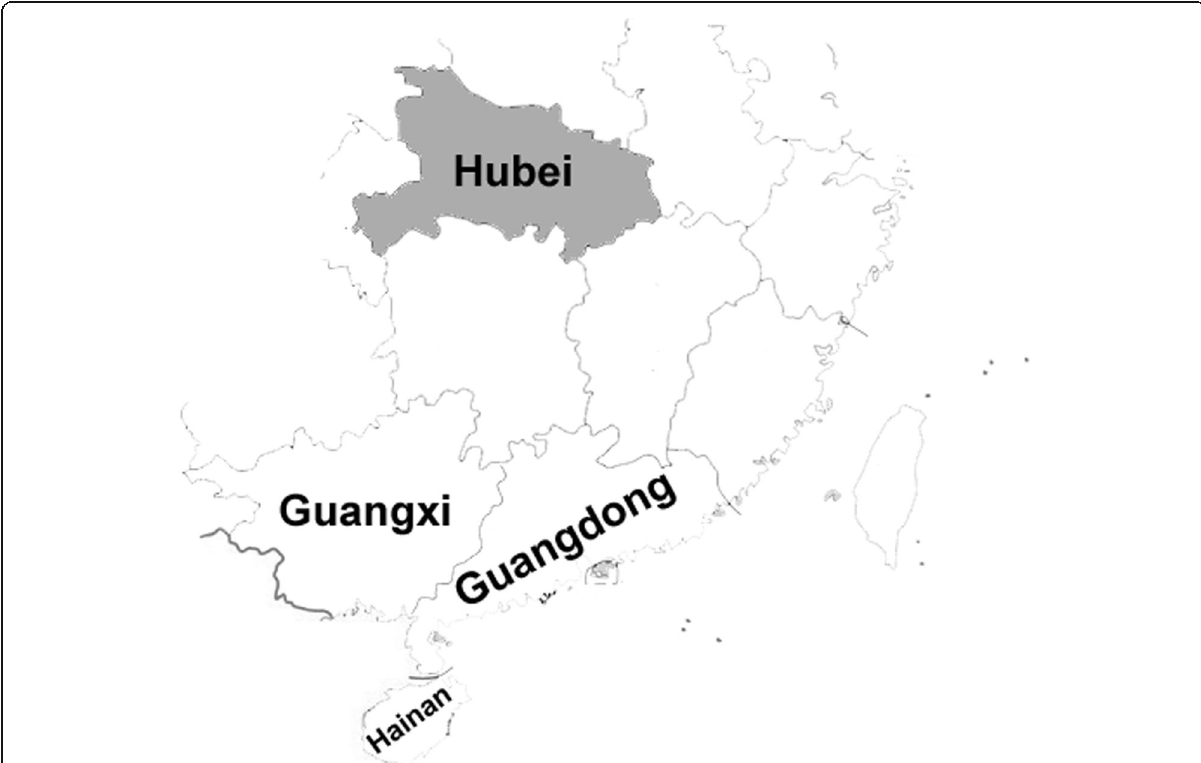
Fig. 1 The part of map of southeastern China, which was drawn by Photoshop 6.0